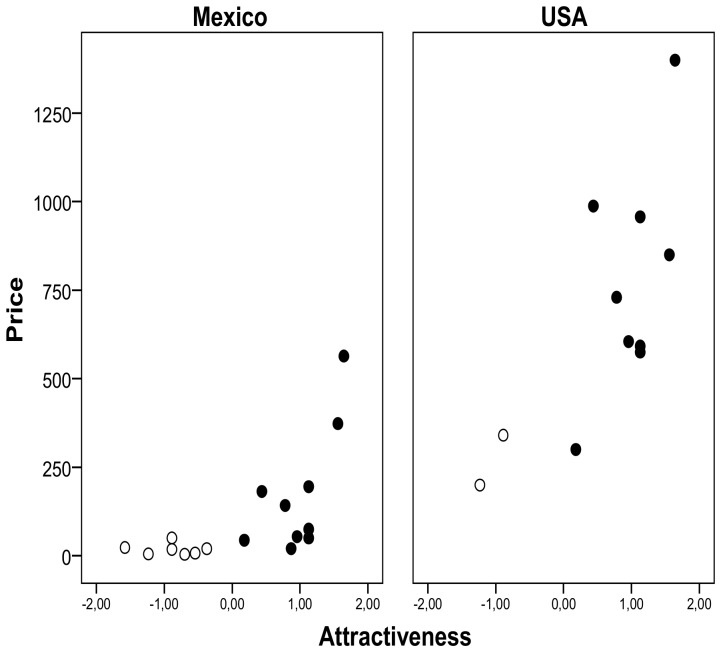
Average price (in US dollars) of Mexican parrots in Mexico and the USA in relation to their attractiveness.Attractiveness scores are those shown in Figure 2. Prices were recorded in 1999–2006. Black dots represent Ara and Amazona species, while empty dots represent other parrot species.